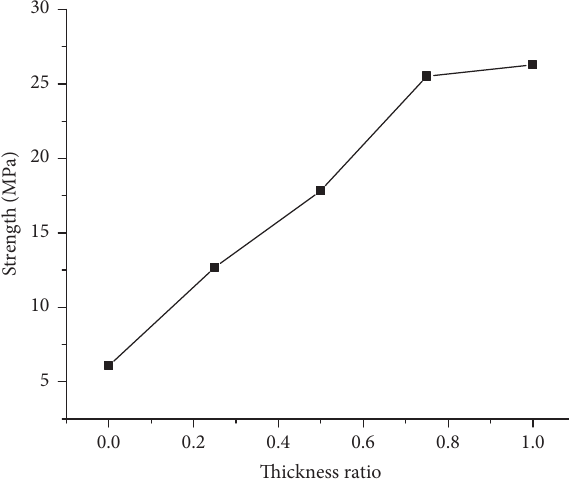
Figure 5: The influence of the thickness ratio of higher strength materials on the strength of specimens.